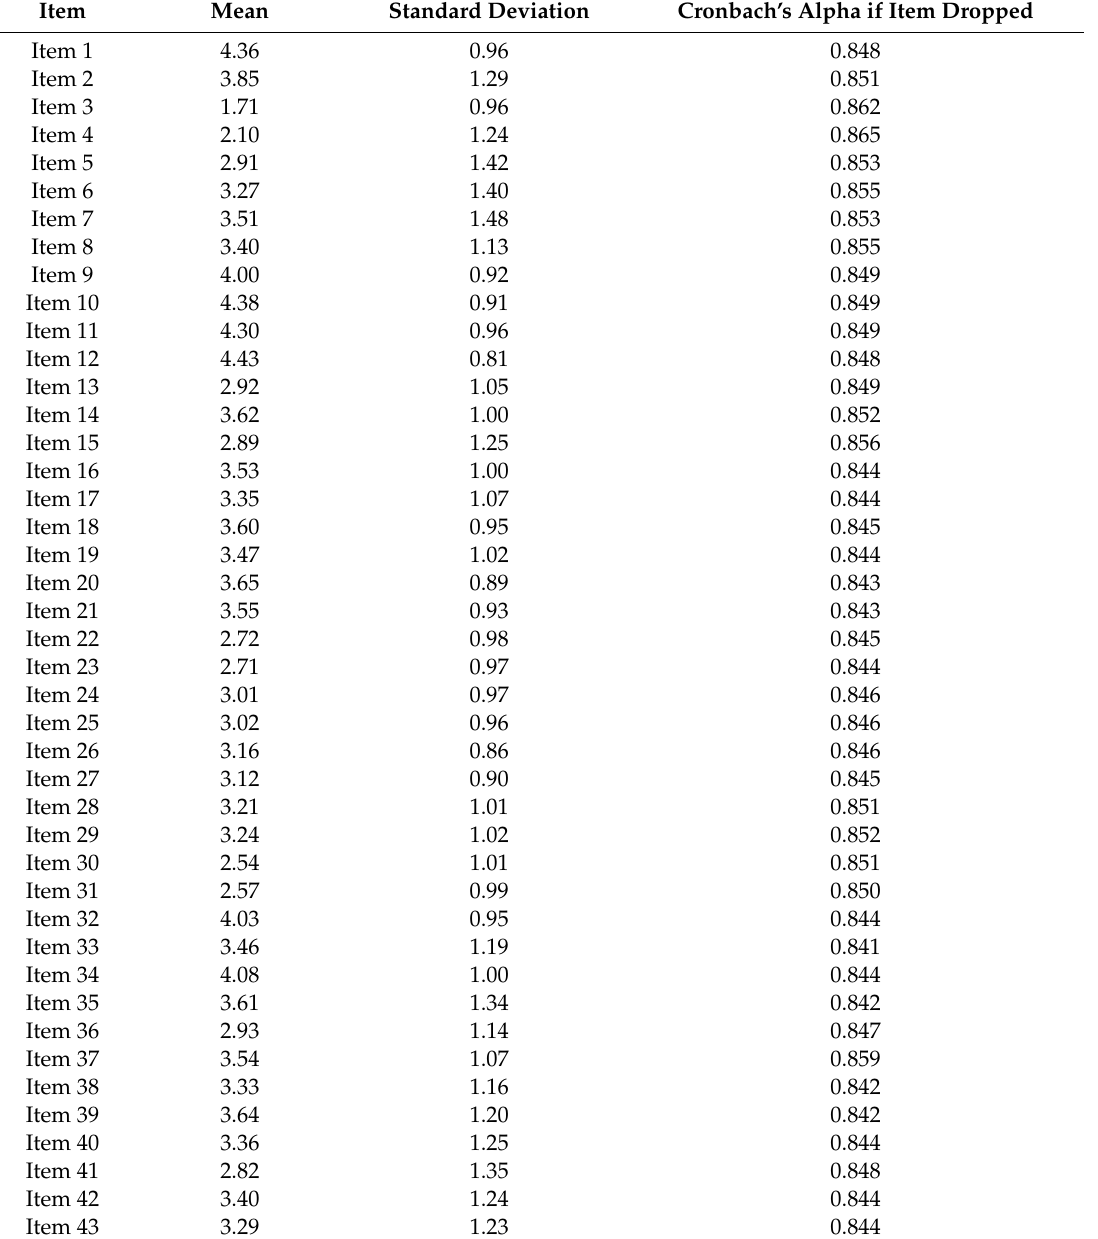
Table 3. Reliability statistics of the third part of the